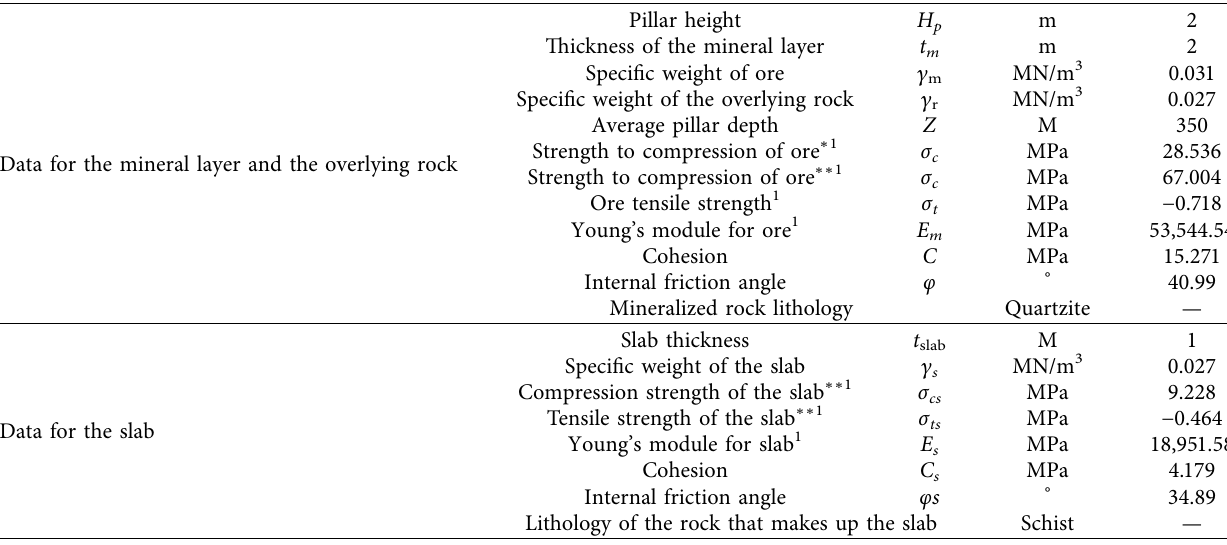
Table 1: Data and geotechnical information.